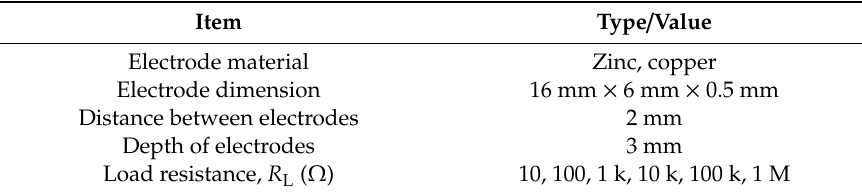
Figure 3. Fruit battery experimental setup. Table 2. Experimental setup.